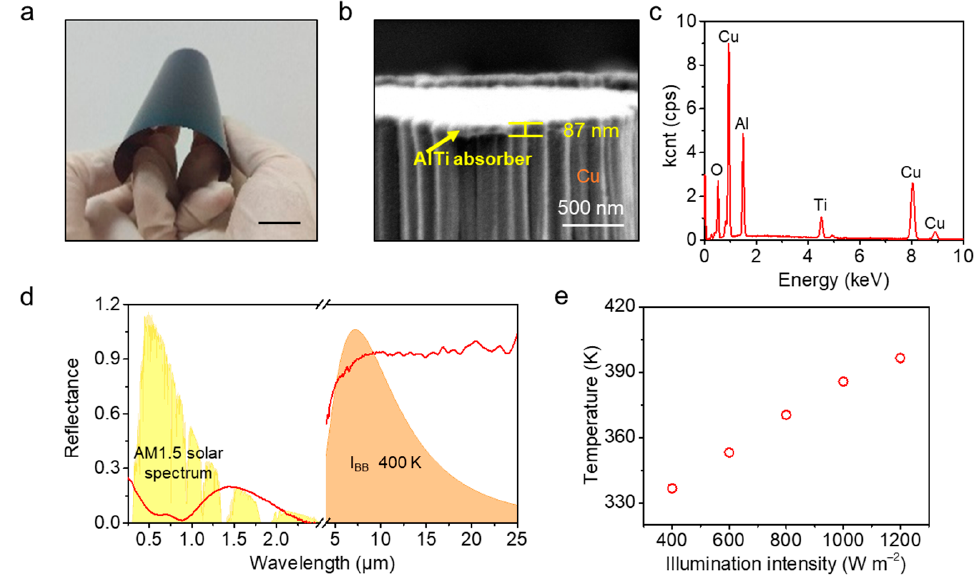
Figure 2. Characterization of the selective adsorbing coating. ( a ) Photograph of the SSA sample. The scale bar is 20 mm. ( b ) The scanning electron microscopy image. The scale bar represents 500 nm. ( c ) Energy-dispersive X-ray spectroscopy. ( d ) The reflectance spectrum of SSA coating. The colored background pattern represents the spectrum of solar radiation AM 1.5G (yellow) and the black-body radiant spectrum at 400 K (orange). ( e ) The steady-state surface temperature of SSA-coated PI thin film under different incident illumination intensities .